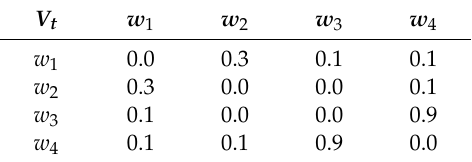
Table 9. Attribute value contradiction degree functions for t ∈ A ( c t